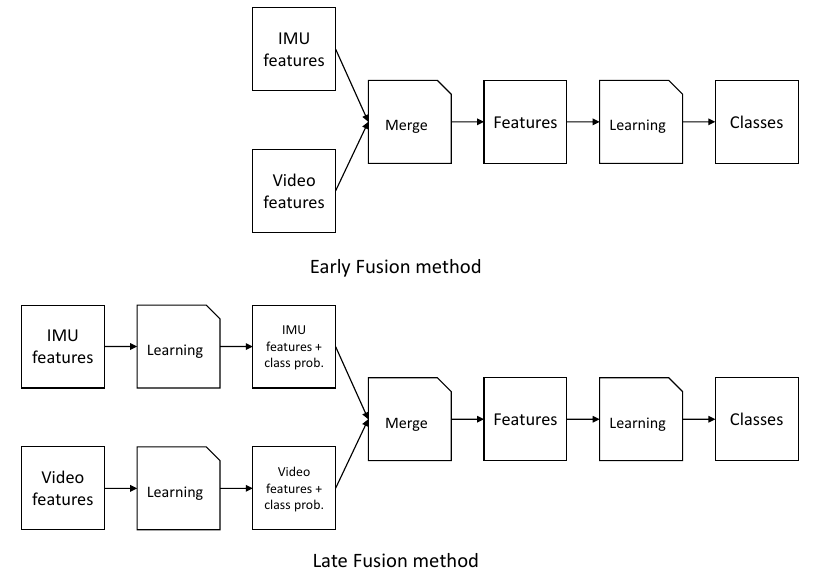
Figure 8. Pipeline for the fusion of the modalities. The top pipeline shows our early fusion method, the bottom one our late fusion